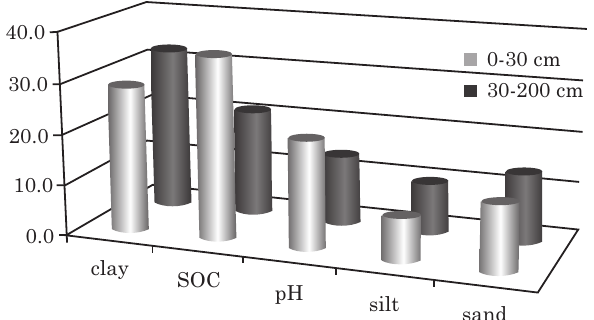
Figure 3. Variances of soil properties expressed as percentage of the overall variance. Sources: Batjes (2008) and Gray et al.